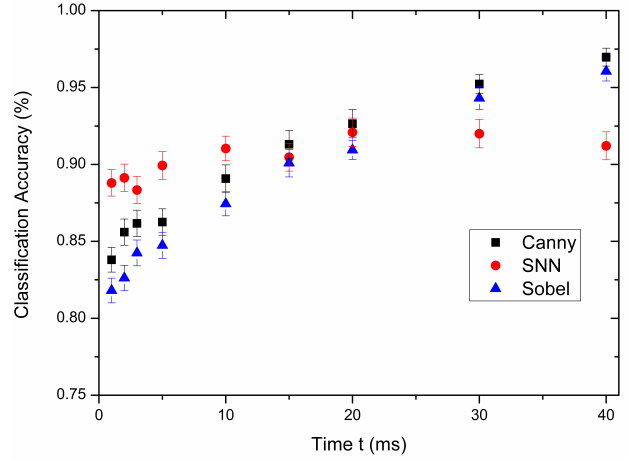
Figure 10. Classification accuracy as a function of number of 1 ms in the image used for edge